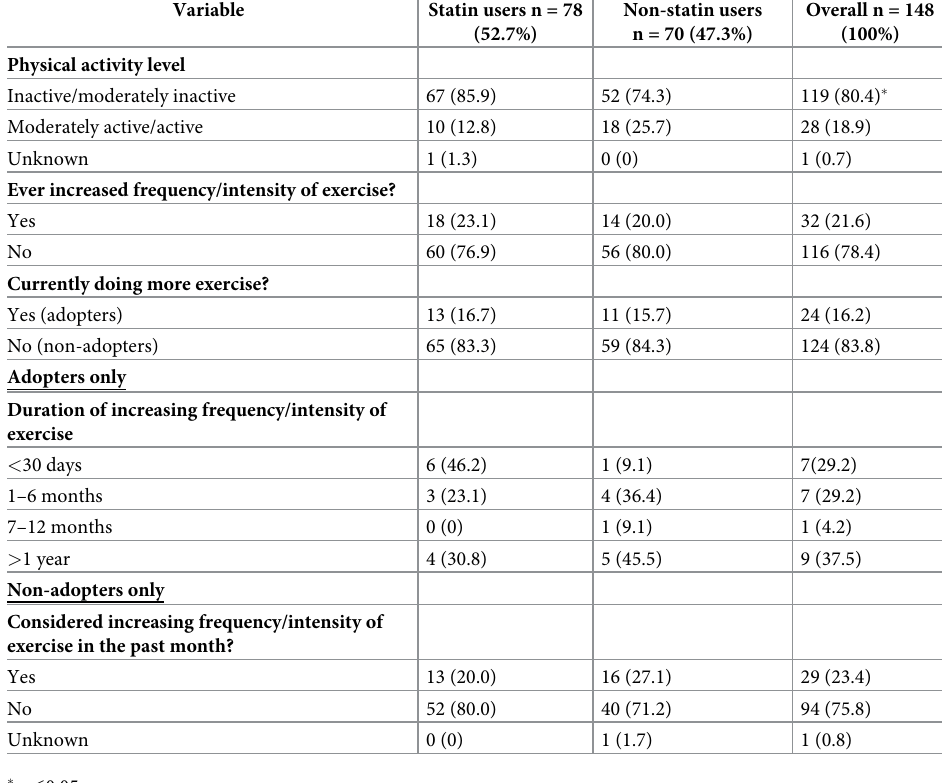
Table 3. Physical activity and exercise patterns of quantitative study